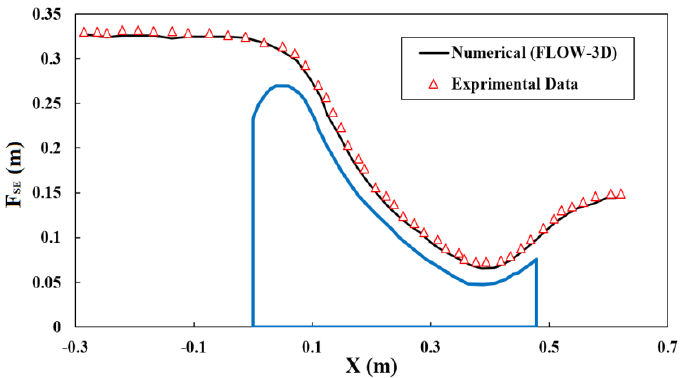
Table 3. Comparison of numerical and experimental free-surface profiles; Q = 0.085 m 3 /s.